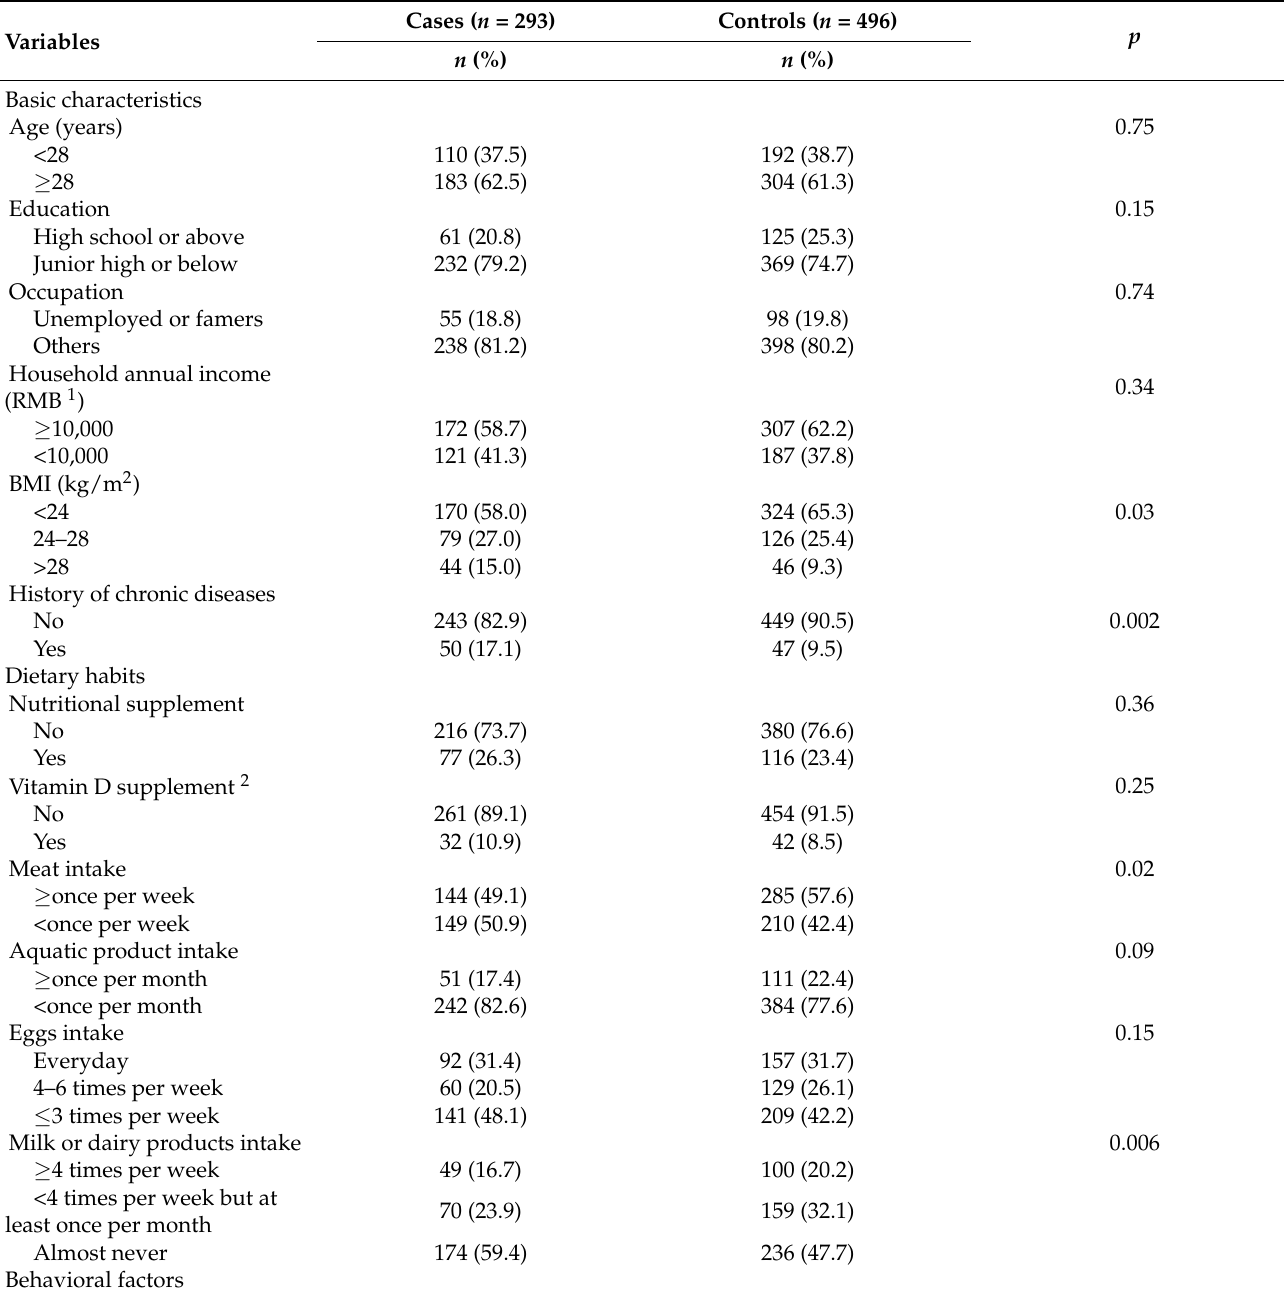
Table 1. Differences in basic characteristics between spontaneous abortion cases and